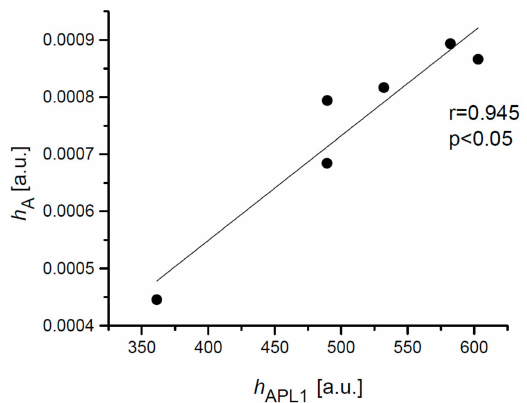
Figure 6. Correlation between the mean height h A of the A oscillations of the second derivative and the mean height h APL1 for 6